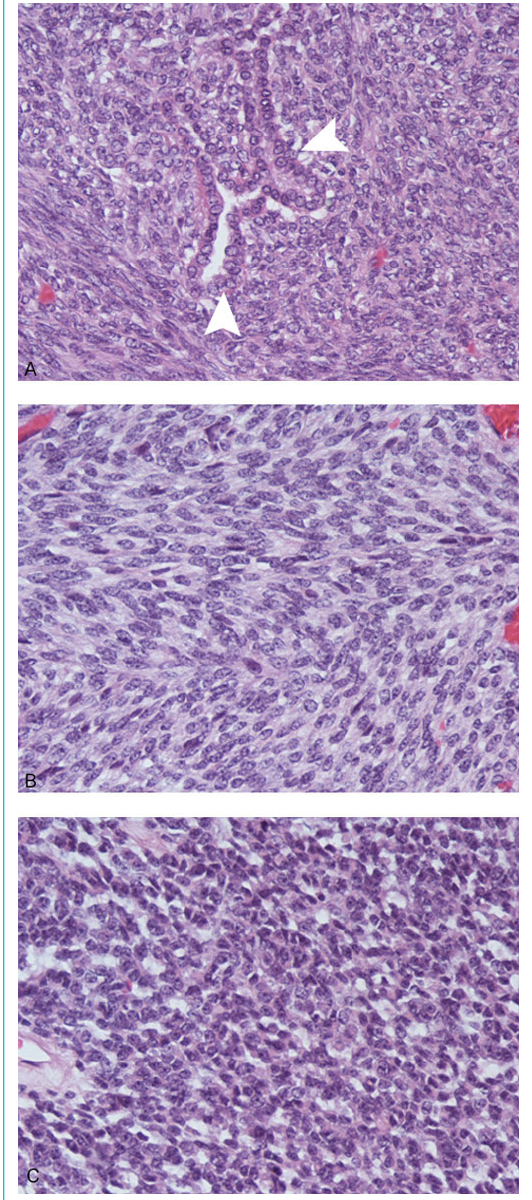
Figure 1: Histology of synovial sarcoma. Top: biphasic synovial sarcoma displaying glandular structures (arrowheads); middle: monophasic synovial sarcoma composed predominantly of dense- ly packed spindle cells; bottom: poorly differentiated synovial sar- coma composed of round cells with scant cytoplasm that falls into the morphologic category of small round blue cell